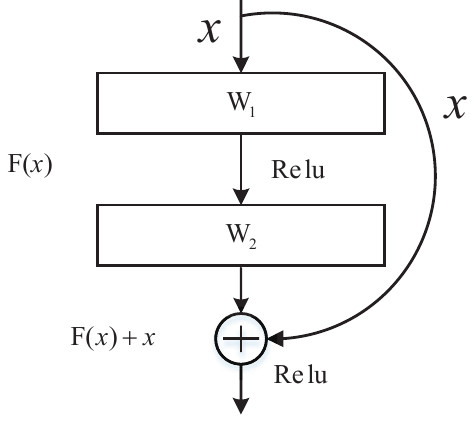
Figure 1. The residual